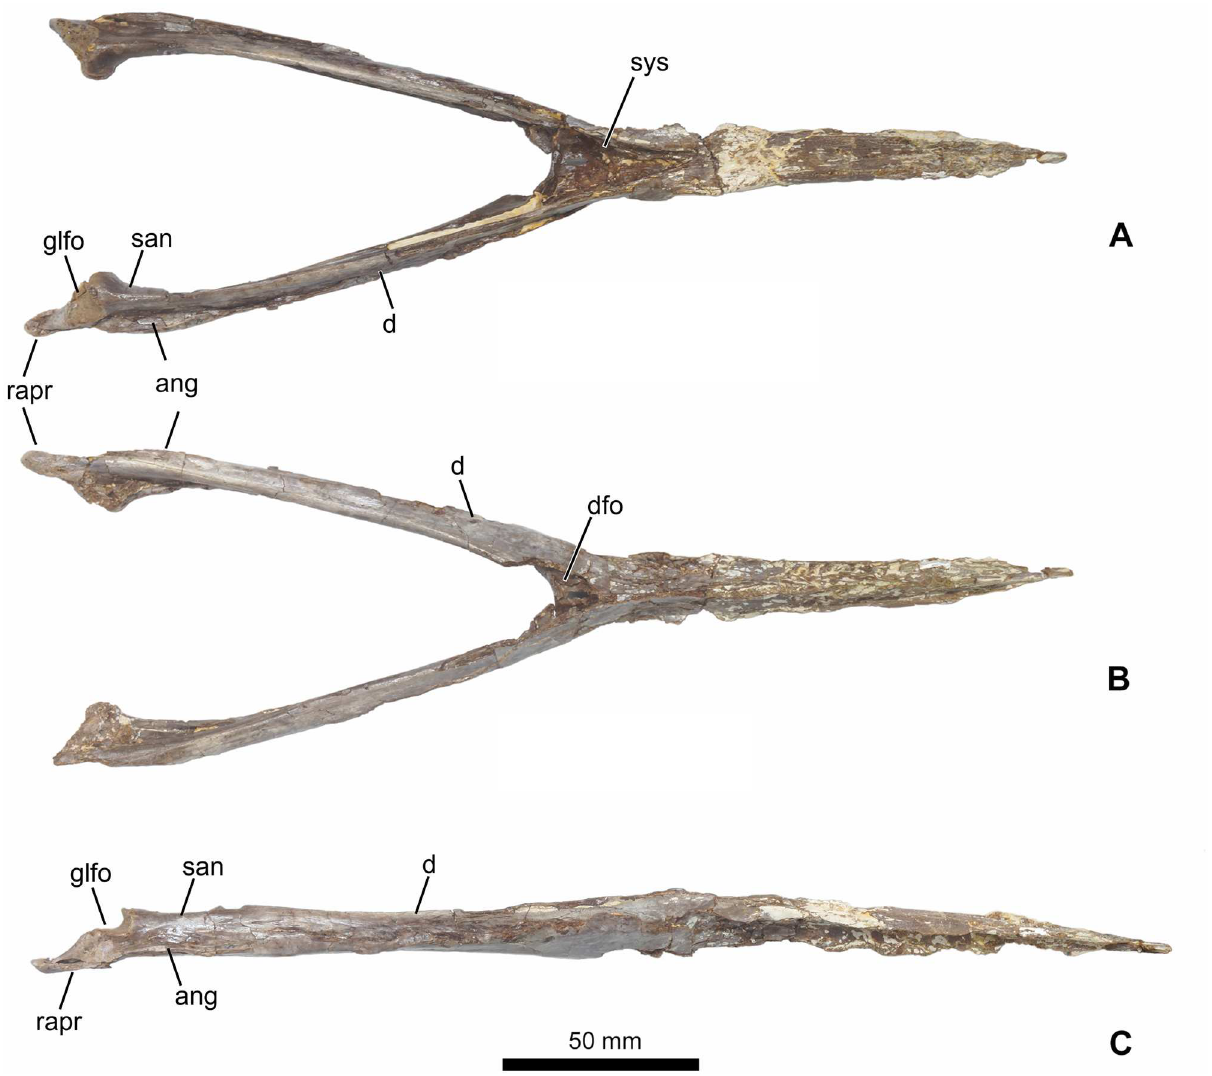
Fig 1. Holotypeof Aymberedactyluscearensis gen.et sp. nov. (MN 7596-V). (A) Dorsalview. (B) Ventral view. (C) Right lateralview. Abbreviations: ang = angular, d = dentary, dfo = dentaryfossa, glfo = glenoidfossa, rapr = retroarticular process, san = surangular, sys = symphyseal